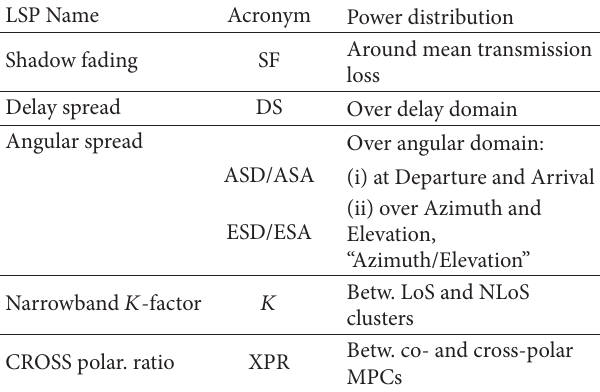
Table 2: Large-scale parameters of WINNER